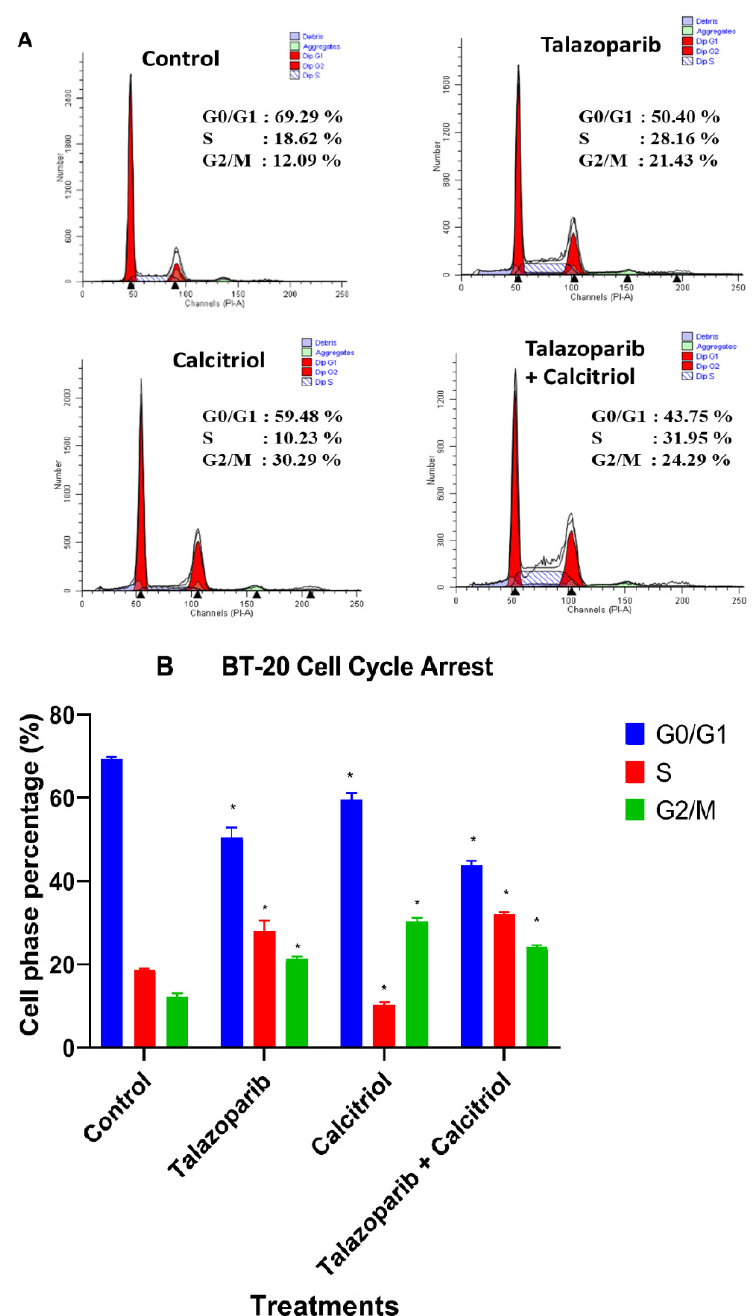
Figure 11. Effect of talazoparib and calcitriol on cell cycle progression in BT − 20 cells. ( A ) FACS analysis (Results are representative of three independent experiments). ( B ) Analysis of the cell cycle with talazoparib, calcitriol and combined treatment. BT − 20 was treated with 91.6 µ M talazoparib and 10 µ M calcitriol for 24 h. In talazoparib and combined treatment, an increase in the populations of G2/M and S phase cells were observed, whereas the population of cells in G0/G1 phase decreased compared to the untreated cells. In calcitriol treatment, an increase in the populations of G2/M phase cells was observed whereas the population of S and G0/G1 phases decreased. The results represent the mean ± SD of three independent experiments. * p < 0.05 vs. untreated control. Data were com- pared between the untreated control and the treatment groups by one − way ANOVA Post Hoc test (Tukey) using SPSS. Raw data and details of statistical analysis can be found in Supplementary S9 and Table S5, respectively.